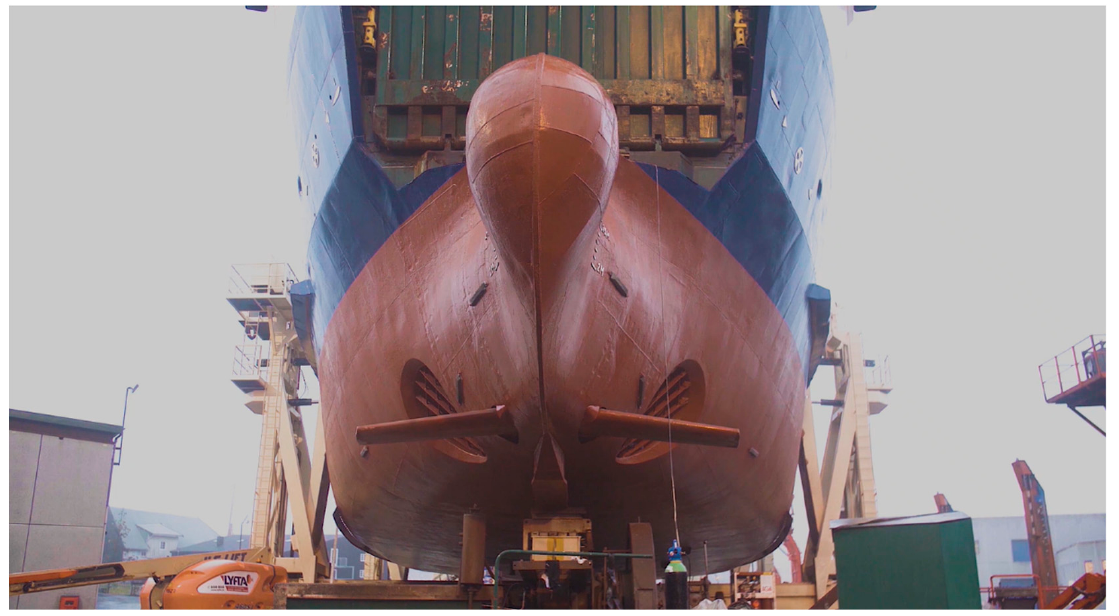
Figure 7. Wavefoil’s retractable bow foil installed on ferry, M/F Teistin (Photo reproduced with permission; copyright Wavefoil).